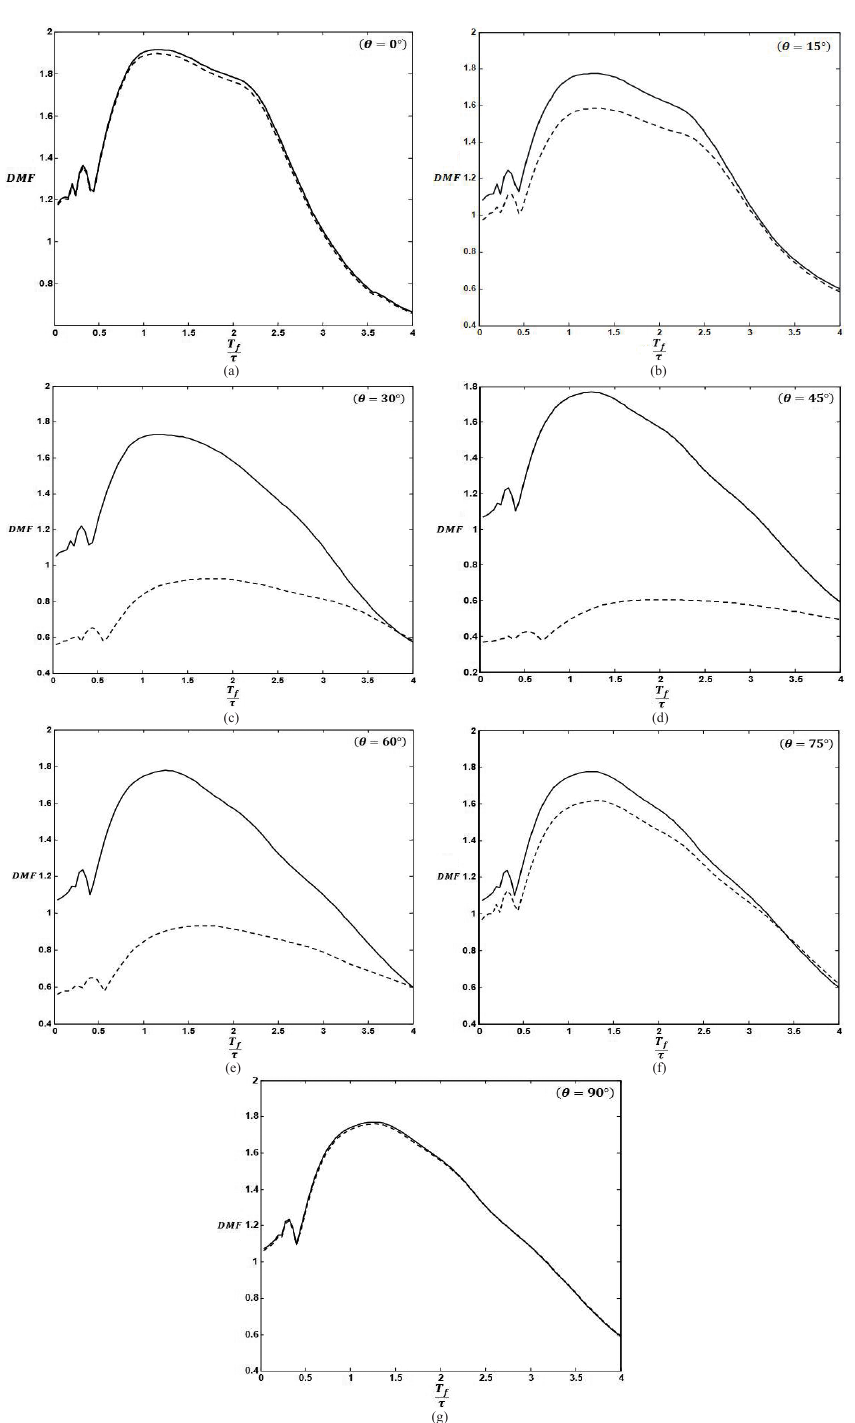
Fig. 8. In fl uence of the Poisson’s effect on the DMF vs. T for symmetric angle-ply beam (—— With considering the Poisson’s effect; – – – – Without considering the Poisson’s